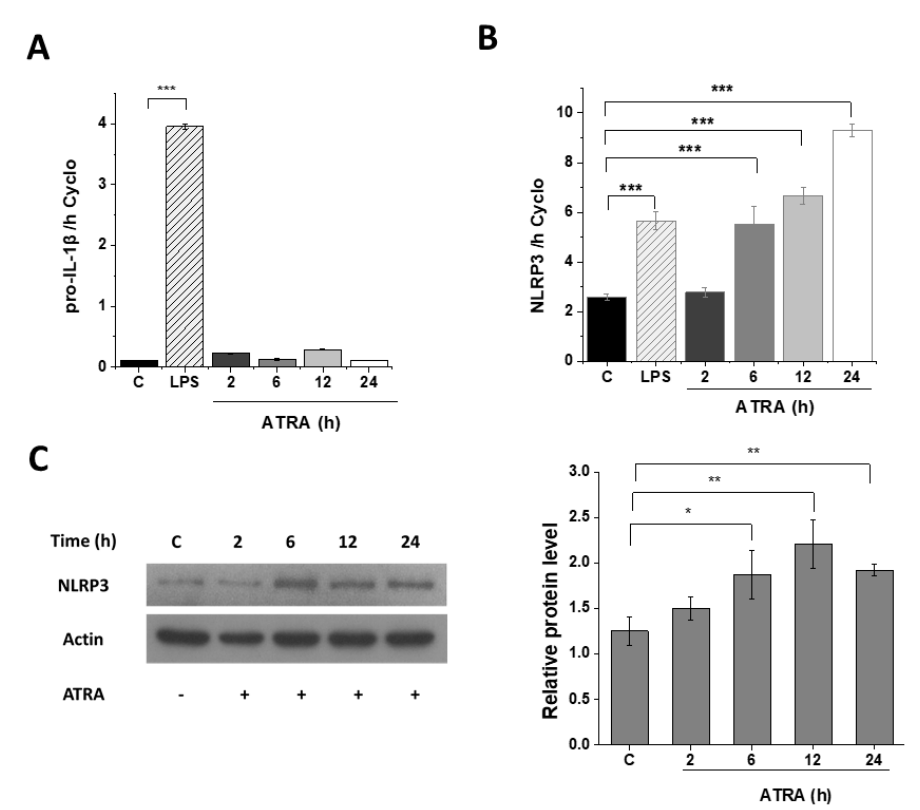
Figure 3. Induction of NLRP3 by ATRA. Relative gene expression of pro-IL-1 β and NLRP3 were measured by quantitative RT-PCR. ( A , B ) M Φ s were treated with ATRA for different time intervals. Here, 6-h LPS-primed cells served as a positive control. ( C ) Representative immunoblot of NLRP3 protein expression of ATRA-treated M Φ s as indicated. β -actin was used as the internal control. C, control (6 h mock-treated cells). The data was obtained from at least four healthy donors. All results are shown as means ± SEM. (* p < 0.05, ** p < 0.01, *** p < 0.001). + , − , presence or absence of indicated substance, respectively